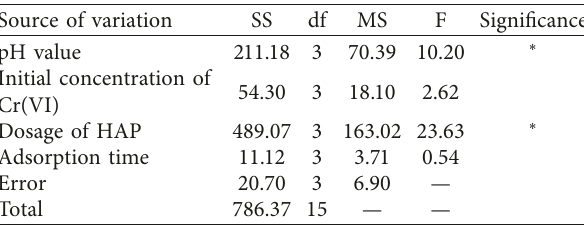
Table 3: Analysis of